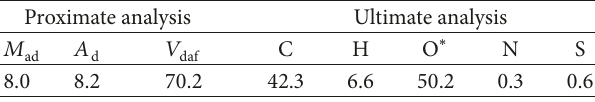
Table 1: Proximate and ultimate analyses (wt.%) of